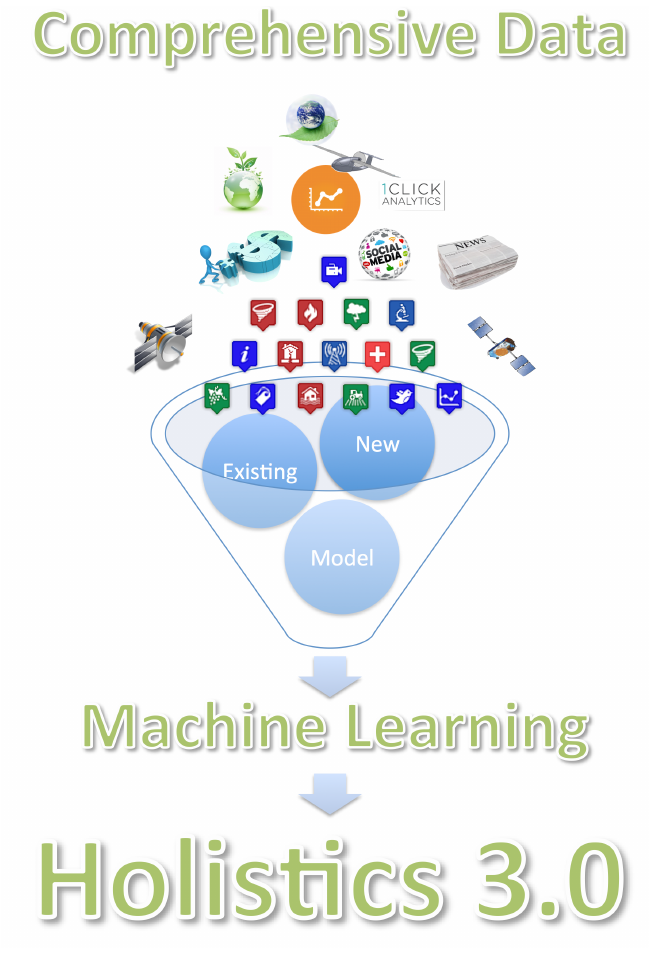
A schematic illustrating the key components of Holistics 3.0: (1) multiple geospatial datasets describing many aspects of a problem holistically; (2) use of machine learning to build empirical decision support tools; and (3) augmentation by inferences about causality. Taken together, this paradigm is called Holistics